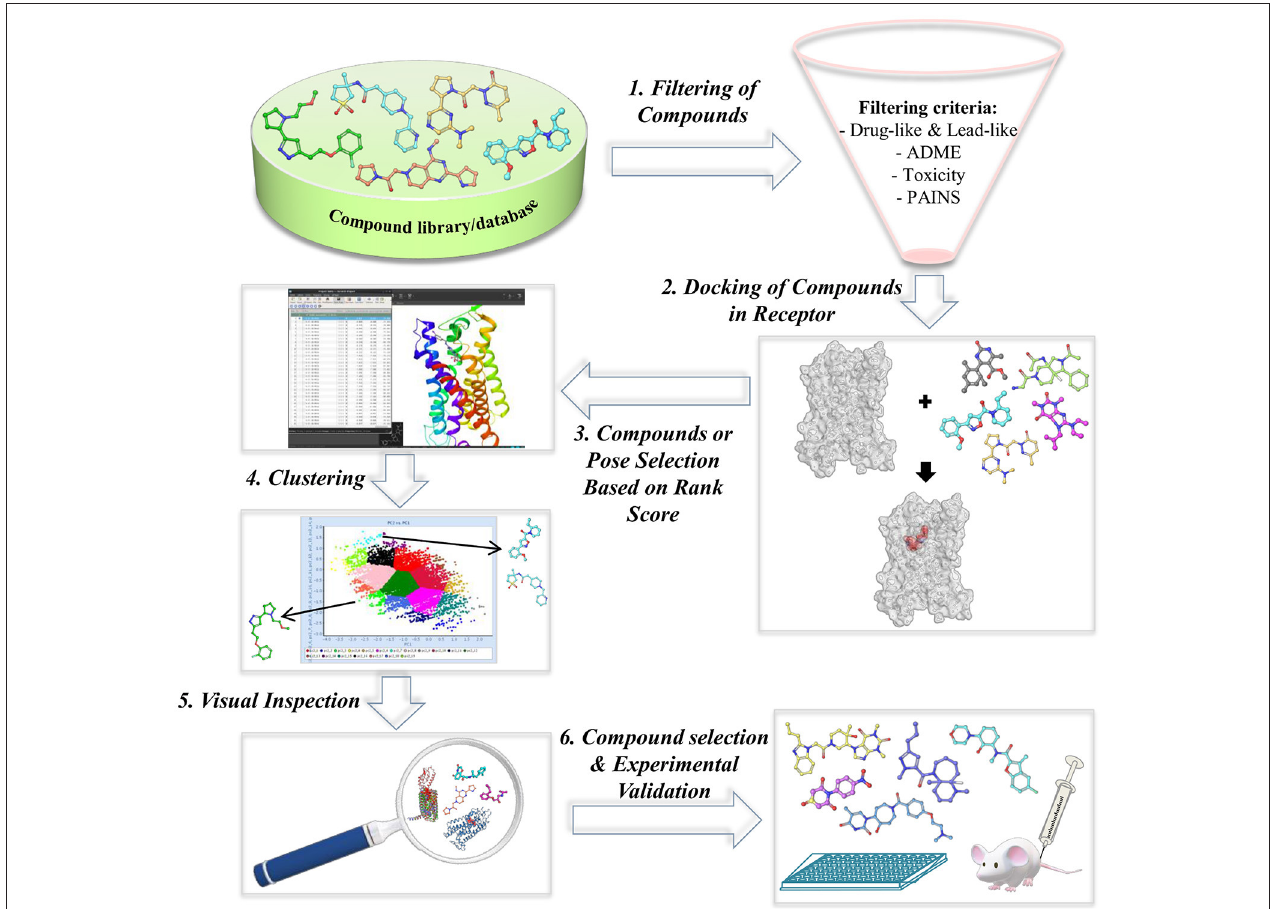
FIGURE 5 | Overview of the typical workflow of structure-based virtual screening (SBVS).